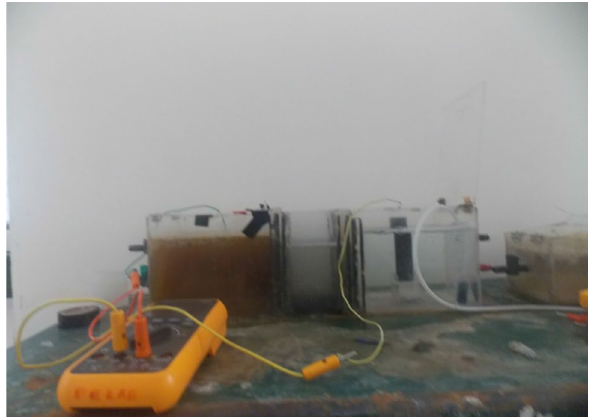
Fig. 2 Laboratory setup of microbial desalination